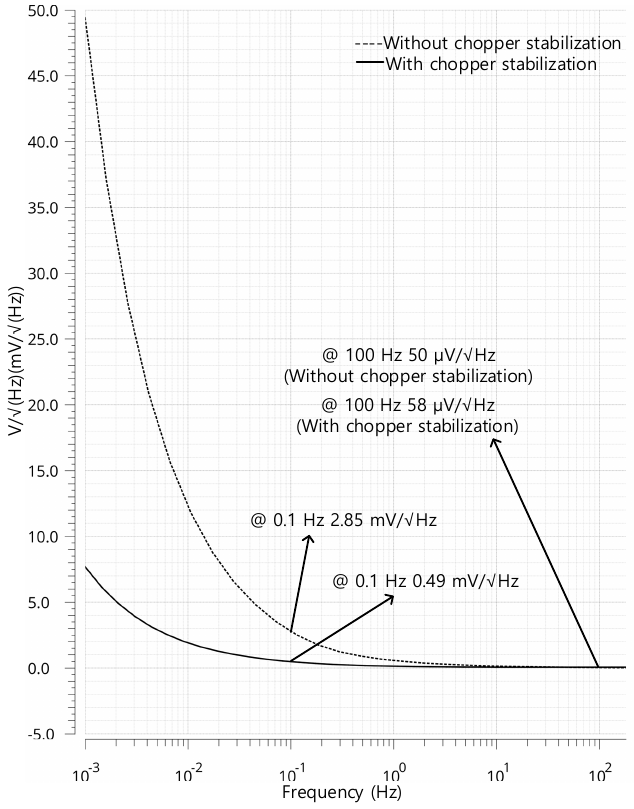
Figure 4. Noise simulation results of the first operational transconductance amplifier (OTA).